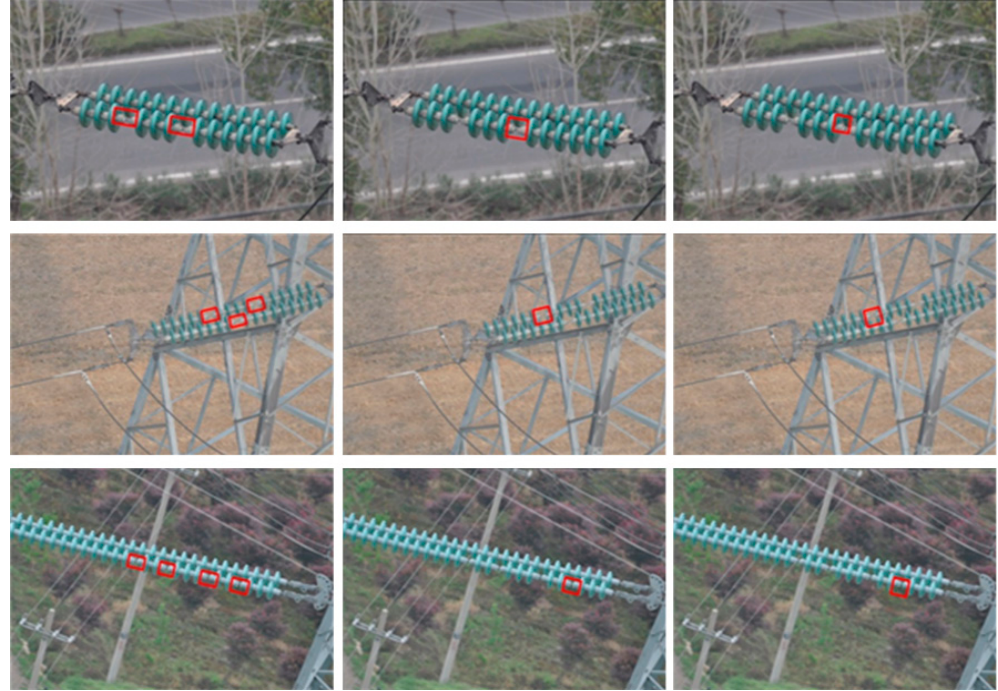
Figure 10. Experimental results in aerial images with insulator multi-fault. In each row, the first column to the third column depicts the performance of the proposed method, method [20], and method [11], respectively.